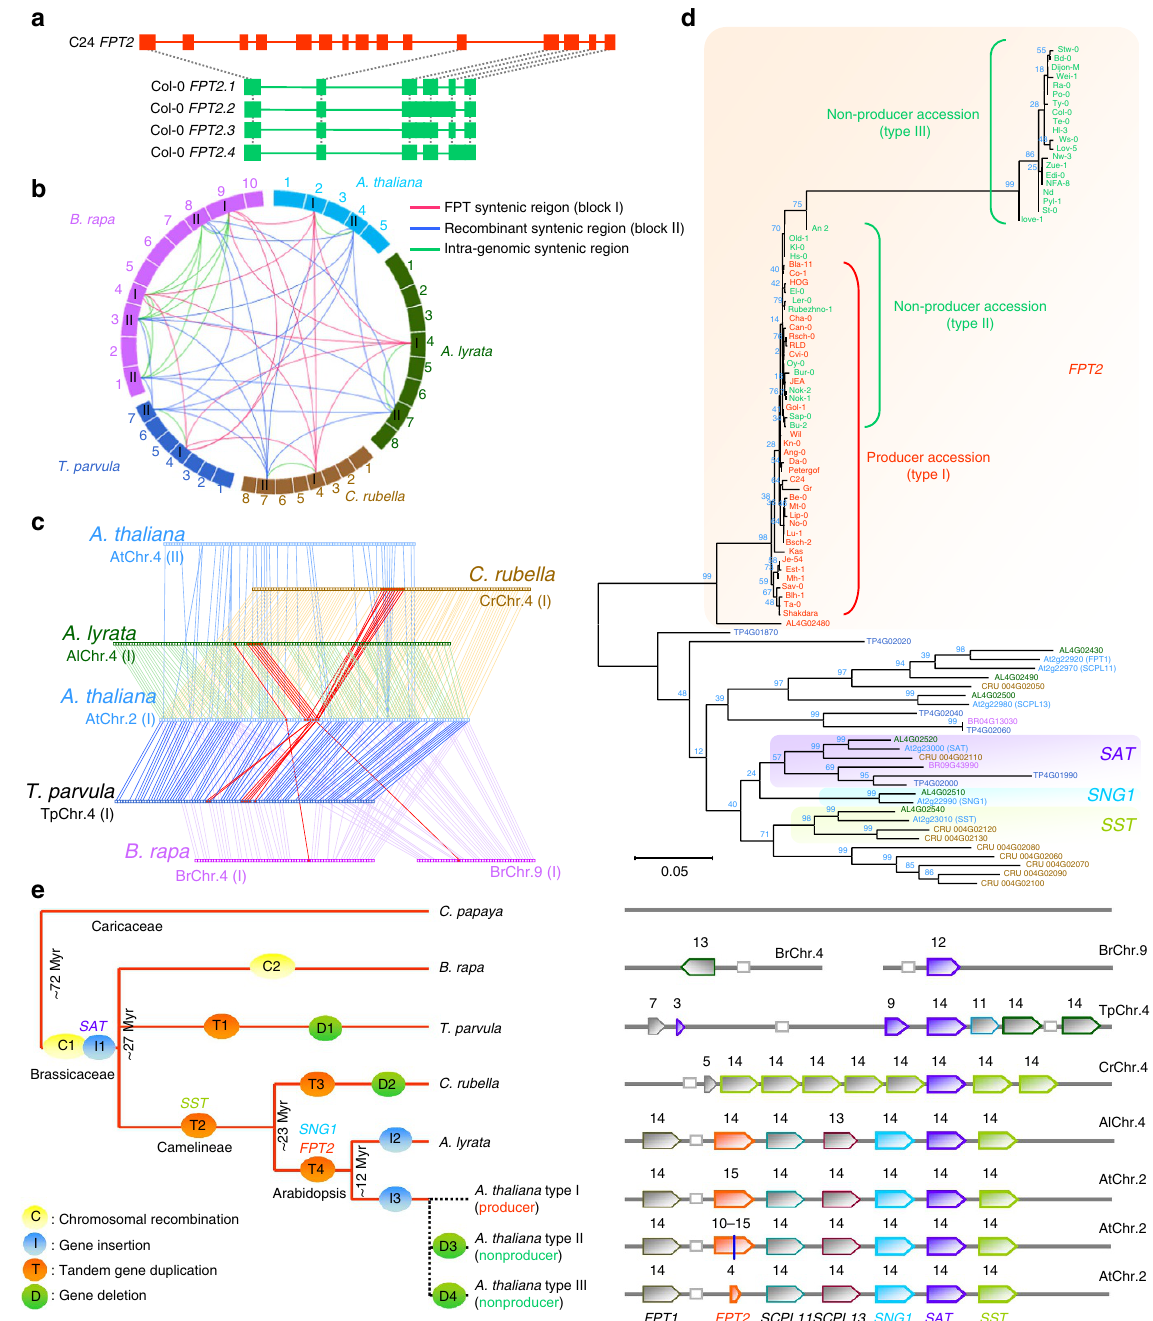
Figure 5 | Genomic structure and sequence analysis of FPT gene cluster region in plant species. ( a ) Gene deletion identified in the FPT2 -Col-0 genomic sequence. Coding sequence including splicing variance found in Col-0 and C24 was mapped with their genomic sequence. ( b ) FPT gene syntenic regions found in plant species. I, red, syntenic block I (containing FPT gene cluster); II, blue, syntenic block II (recombinant syntenic region); green, linkage of intra-genomic syntenic region. ( c ) Syntenic gene linkage between plant species. Red box and line indicate FPT / SCPL genes. Similarity between AtSCPL and SCPL genes obtained from Brassicaceae species is evaluated by TAIR-BLAST (https://www.arabidopsis.org/). ( d ) Phylogenetic analysis using CDS of SCPL genes in syntenic region of Brassicaceae species. A short gene TP4G01860 was excluded from this analysis. The phylogenetic tree was created using MEGA5.2 (ref. 60). Scale implies nucleotide substitutions per site. ( e ) Hypothetical scheme of evolutional events in FPT gene cluster region among Brassicaceae species. The taxonomical tree of Brassicaceae species was constructed via reference to PLAZA (http://bioinformatics.psb.ugent.be/plaza/) based on NCBI taxonomic analysis (http://www.ncbi.nlm.nih.gov/taxonomy). FPT tandem duplication cluster of SCPL genes including FPT1 and FPT2 . Numbers above genes indicate number of exons. Red, yellow and blue indicate sub-clades found by phylogenetic trees analysis in d . C1 and C2, chromosomal recombination in Brassicaceae and B. rapa , respectively; I1, hypothetical time of SAT insertion into FPT region; I2, gene insertion into fourth and eleventh exons of AL4G02540; I3, gene insertion into second intron of FPT2 ; T1–4, tandem gene duplication in T. parvula , Camelineae ( C. rubella, A. lyrata and A. thaliana ), C. rubella and Arabidopsis ( A. lyrata and A. thaliana ), respectively; D1–4, gene deletion in T. parvula , C. rubella , A. thaliana non-producer type II and type III.